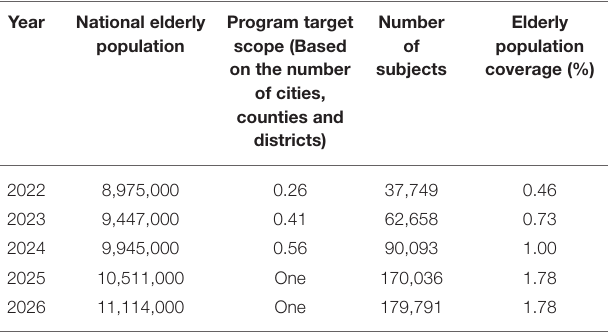
TABLE 7 | Estimation of recipients of integrated care for the elderly in the local